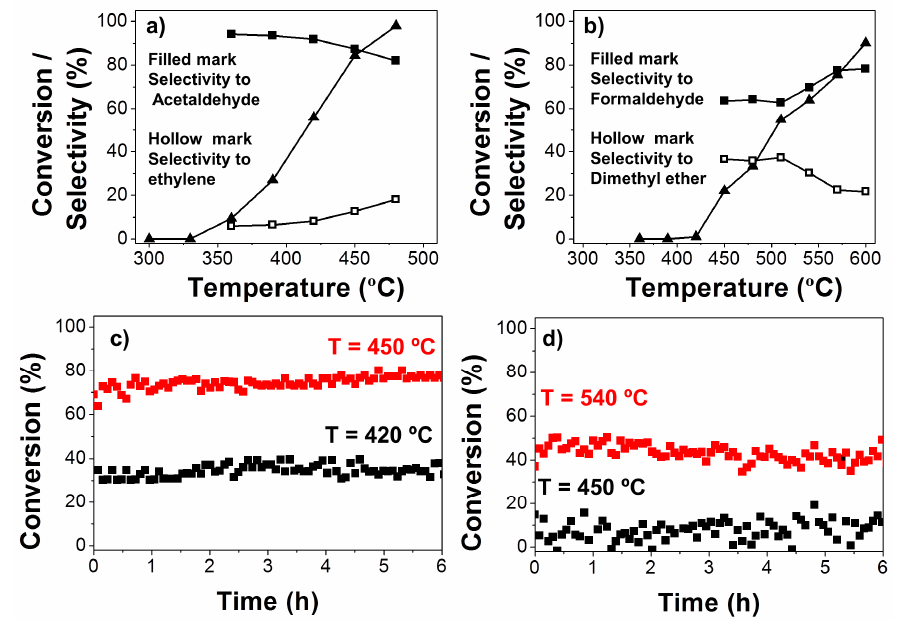
Figure 7. Evolution of the steady-state conversions of ethanol ( a ) and methanol ( b ) and selectivity to aldehydes and ketones (filled marks) and olefins and ethers (hollow marks) with the temperature for all the carbon catalysts in a helium flow (Po ALC = 0.0185 atm; W/Fo ALC = 0.073 g s µ mol − 1 ); ethanol ( c ) and methanol ( d ) conversions as a function of time on stream at different temperatures with Po ALC = 0.0185 atm and W/Fo ALC = 0.073 g s µ mol − 1 .